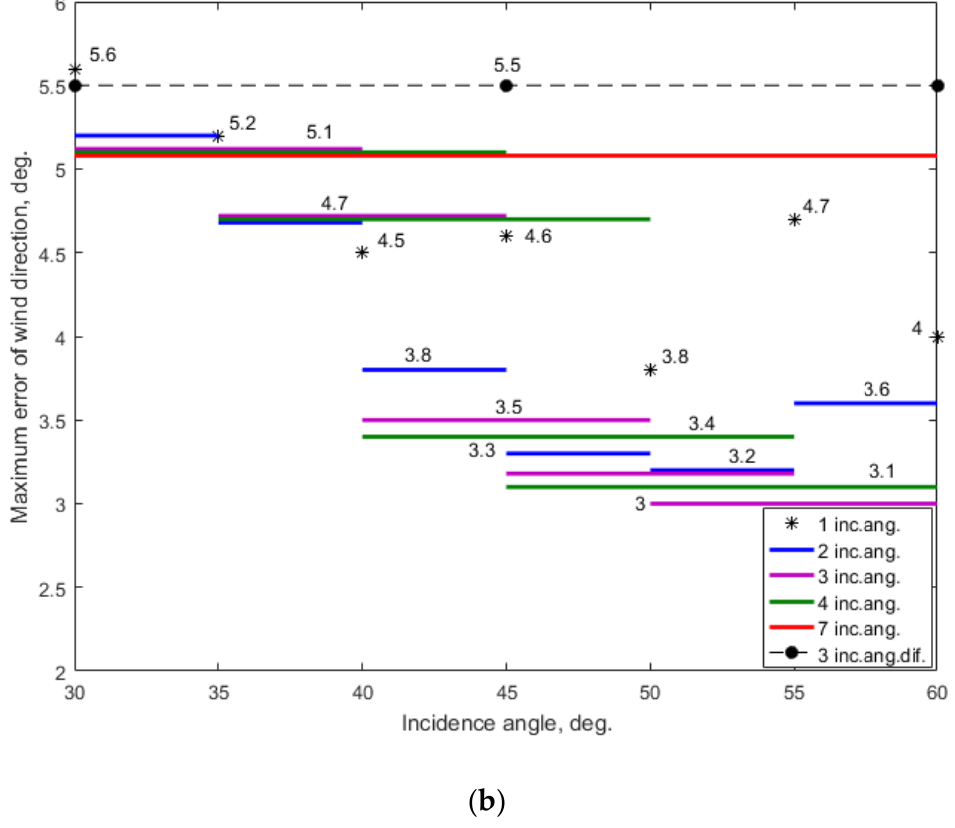
Figure 3. Comparative results for the maximum wind retrieval errors in accordance with the cases considered: ( a ) maximum error of the wind speed; ( b ) maximum error of the wind direction. The black asterisks represent the wind retrieval when one incidence angle was used; the blue lines represent the wind retrieval when two incidence angles were used; the purple lines represent the wind retrieval when three incidence angles were used; the green lines represent the wind retrieval when four incidence angles were used; the red line represents the wind retrieval when seven incidence angles were used; the black dashed line with dots represents the wind retrieval when three incidence angles were used but with a 15° incidence angle difference between the neighboring incidence angles in the range of considered incidence angles of 30° to 60°.